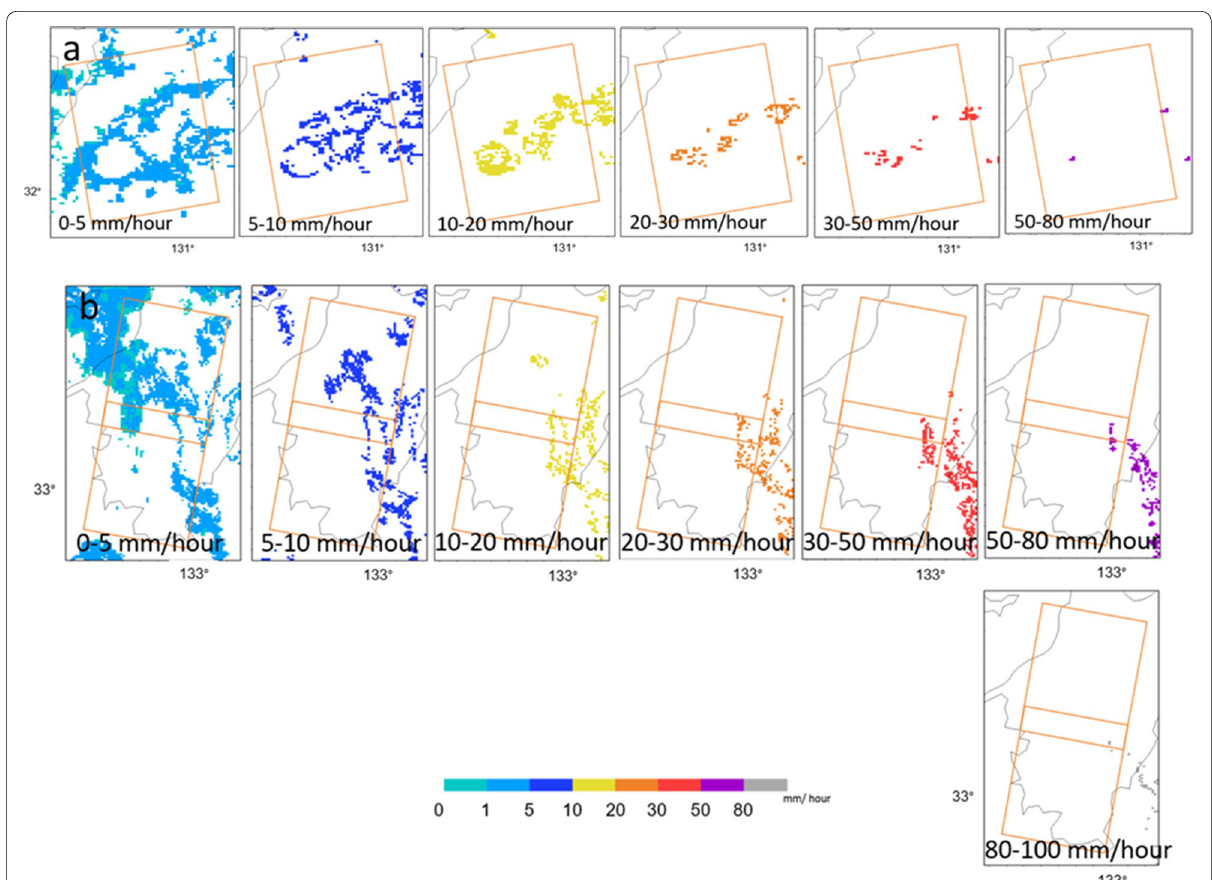
Fig. 9 Rain rate ranges over ( a ) Kyushu on 20,180,731 at 1520UTC and ( b ) Shikoku on 20180815 at 0310UTC. Orange squares denote the SAR imaging area taken by ALOS-2/PALSAR-2 SM-1 mode. Colors indicate rain rate in